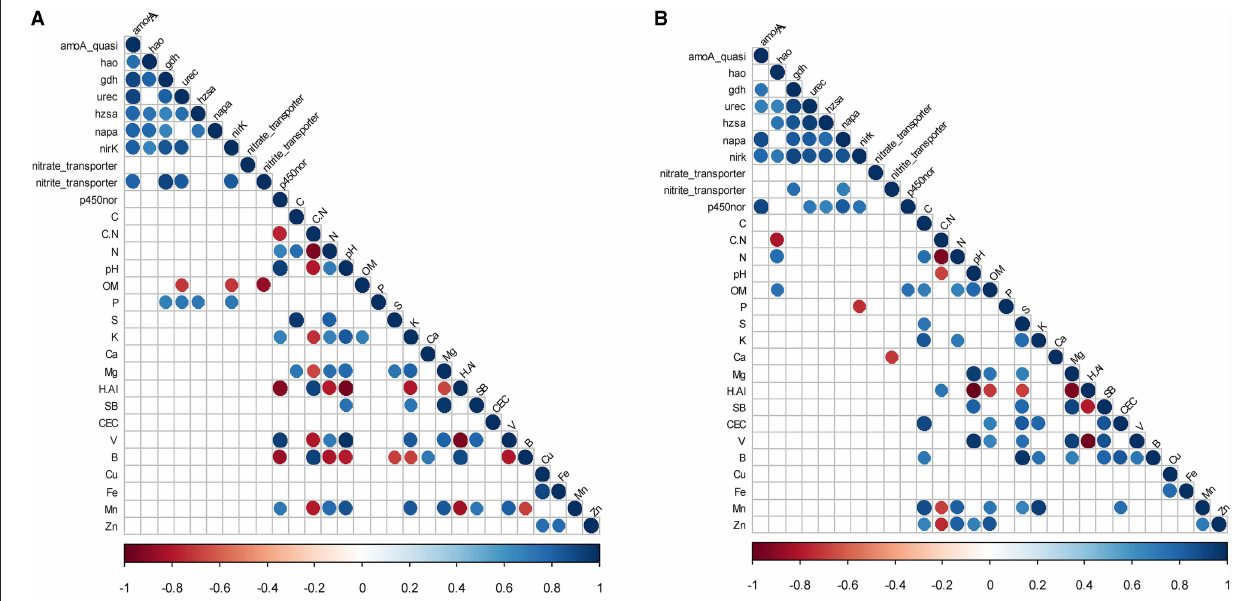
FIGURE 1 | Heatmap correlation test between GeoChip v.5.0M gene families responsive to N treatments and physicochemical soil factors, according to significant values ( p < 0.05) of Spearman rank correlation coefficients performed in the R environment with the “Hminsk and CorrPlot” package. (A) Sample collection 7 days after fertilizer addition; (B) Sample collection 150 days after fertilizer addition. Positive values (blue circles) represent positive correlations, and negative values (red circles) represent negative correlations.